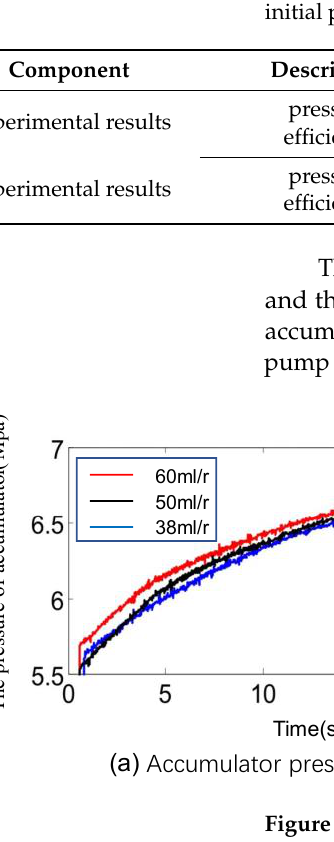
Figure 7. Pressure change diagram of the accumulator under different displacement rates.